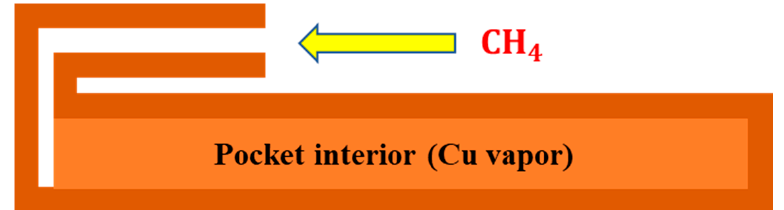
Figure 6. A schematic drawing of the cross-section of Cu pocket showing the CH 4 transport channel into the pocket interior environment.